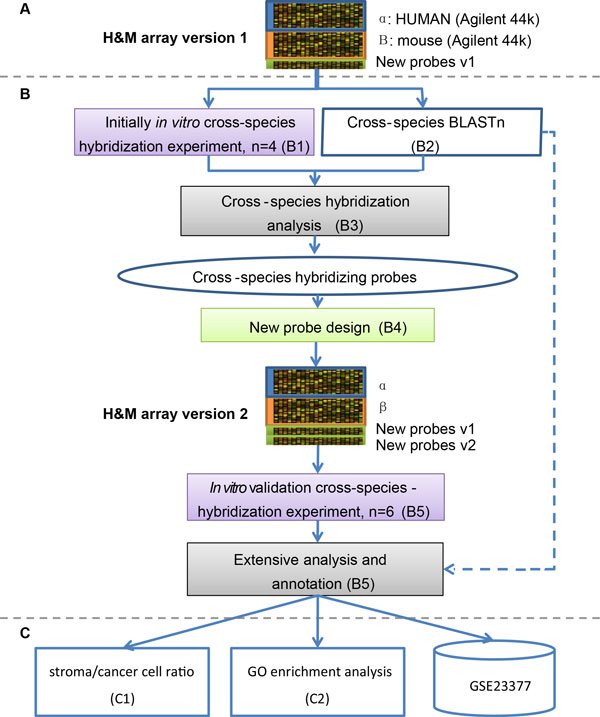
Schematic diagram for the biological and computational design and annotation of the H&M microarray. The whole array design and analysis includes three stages, as described in the Materials and Methods Section. There were 3.6k newly designed probes in step A and 7.1k newly designed probes in step B. All probes on H&M (Agilent GEO platform GPL10749) were optimally and extensively annotated for cross-species hybridization as shown in Dataset S1. The Agilent pre-annotated cross-species hybridization probes from step A are given in Datasets S2-3, and the processes used to design the new probes in version 1 were previously published [17].